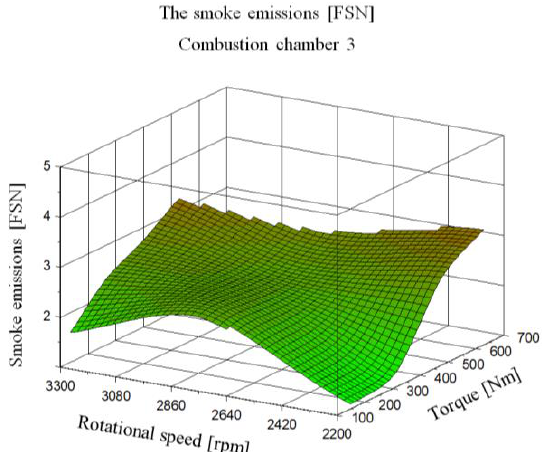
Figure 28. The smoke emission of the engine equipped with the combustion chamber 3.